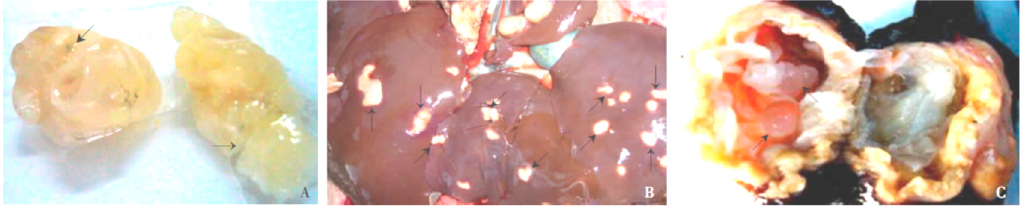
Figure 3. ( A ) Metacestodes of E. multilocularis in rodents with daughter cysts ( → ). ( B ) Uneven surface of the liver containing about 20 metacestodes of E. granulosus ( → ). ( C ) Typical metacestodes of E. granulosus with daughter cysts ( → ) in livers of sheep. Cyst walls showing extensive fibrosis.